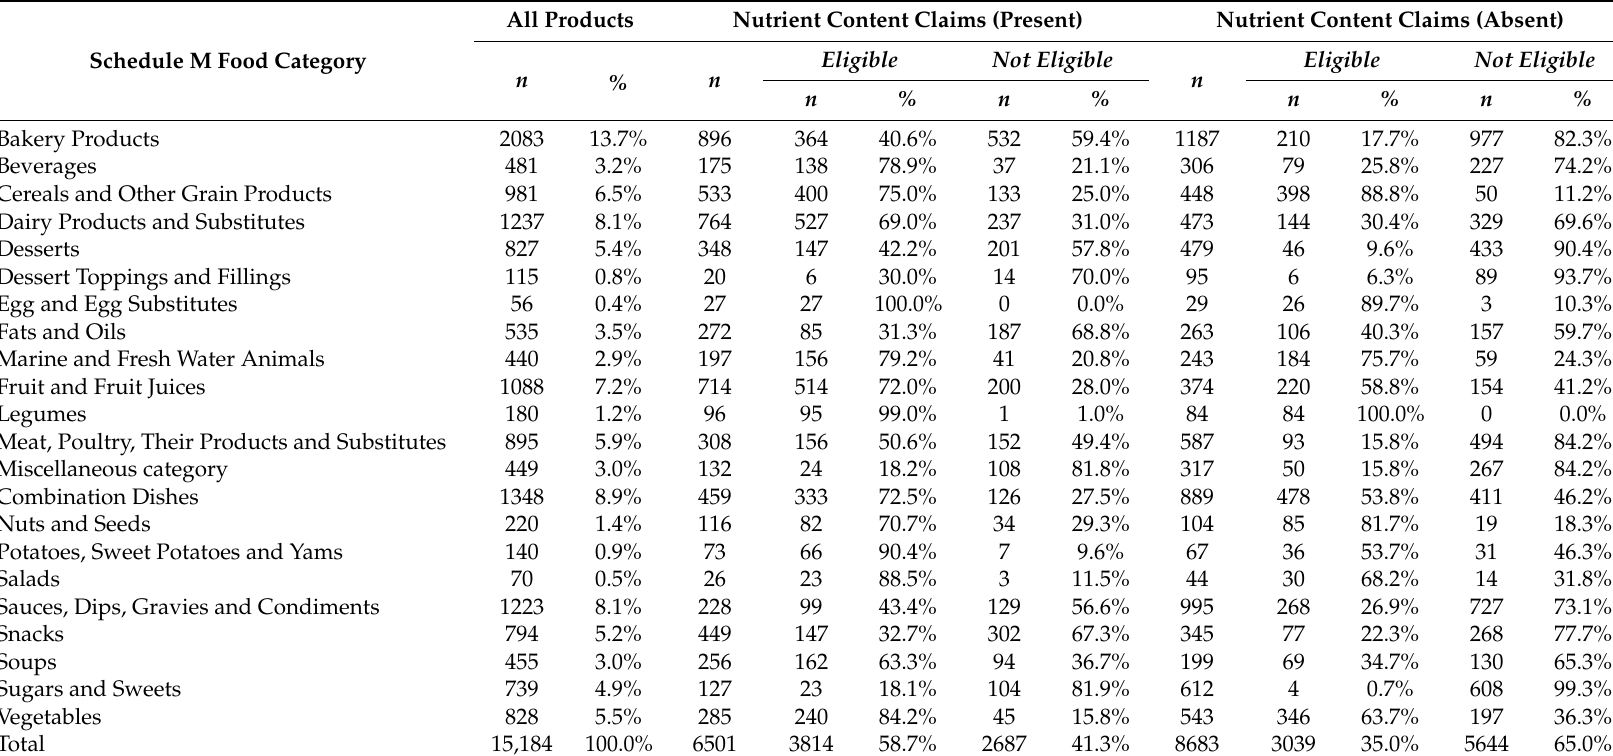
Table 2. Proportion of foods and beverages carrying nutrient content claims that would or would not be eligible to carry such claims according to the FSANZ-NPSC, by Schedule M food category ( n =